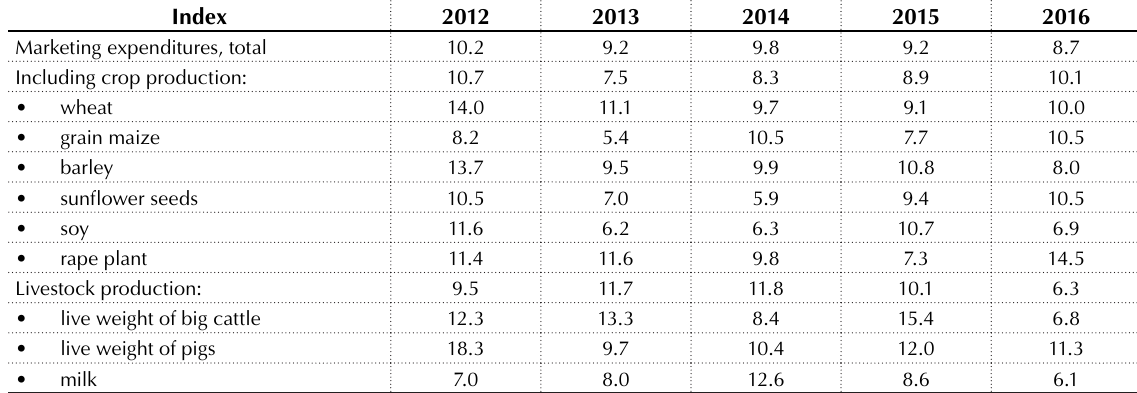
Table 8. Share of marketing expenditures in full cost of sold agricultural products of Khrystynivka district, Cherkasy region Source: Calculated according to the data of agricultural enterprises’ reporting.